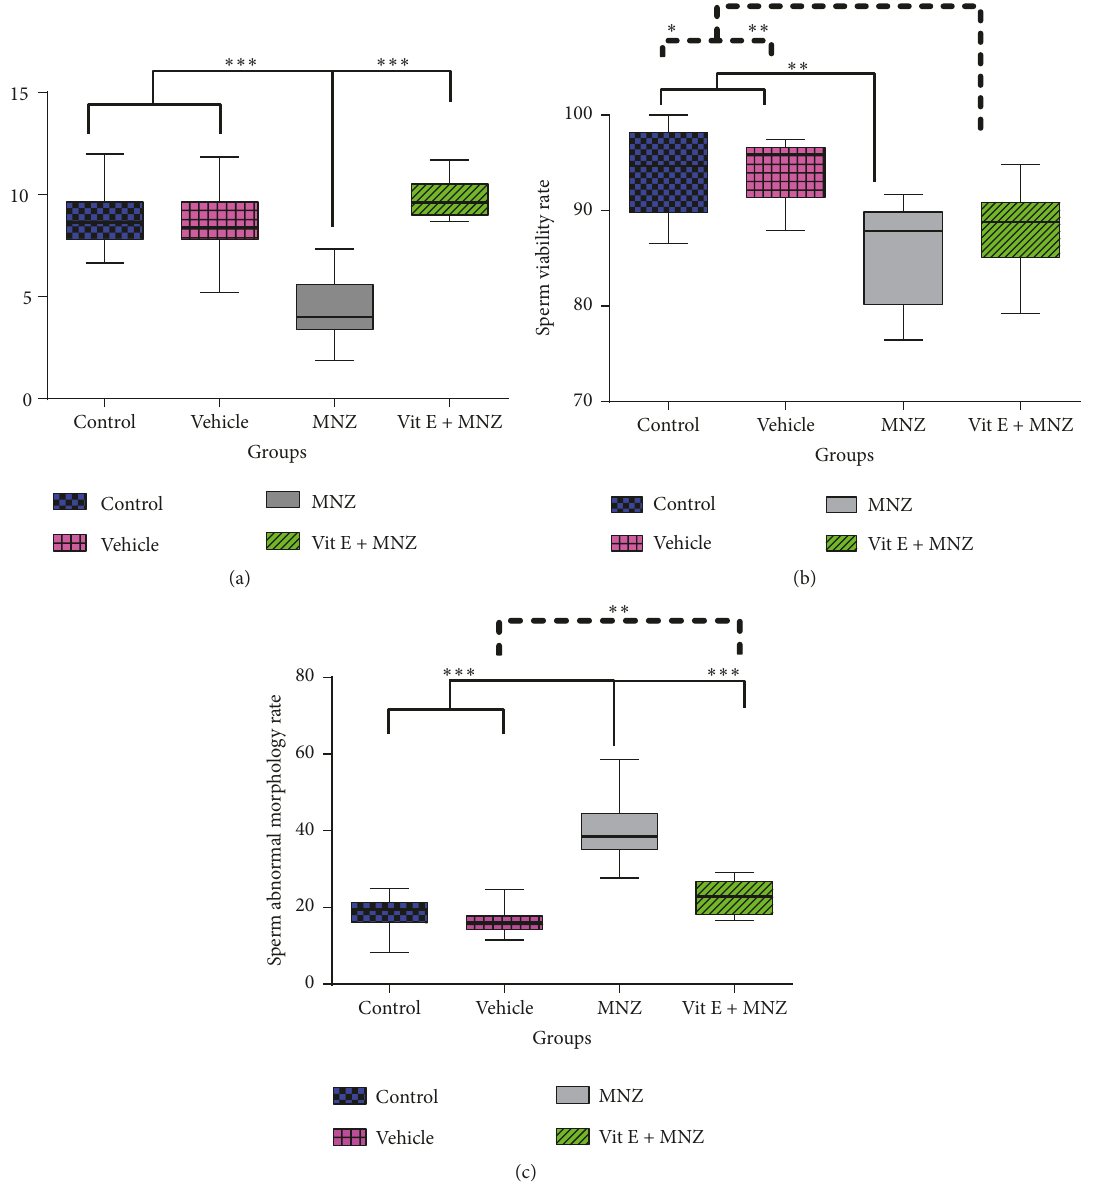
Figure 1: The effect of mancozeb administration alone and with vitamin E during intrauterine life and lactating periods on sperm count (a), viability (b), and abnormal morphology (c) in the different groups (n=10). MNZ: mancozeb. ∗ , ∗∗ , and ∗ ∗ ∗ indicate p < 0.05, p < 0.01, and p < 0.001,